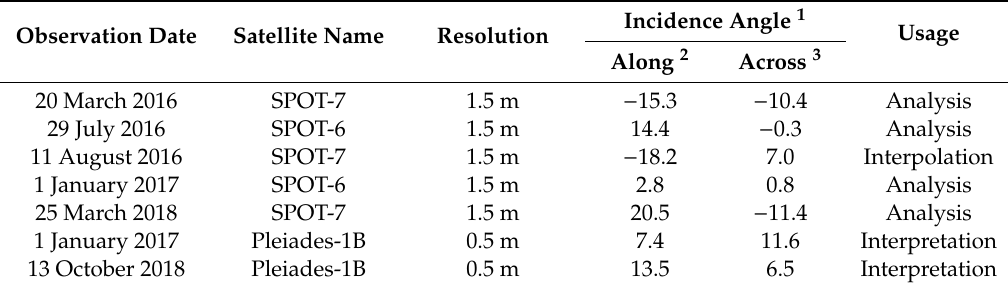
Table 1. List of satellite images selected in this